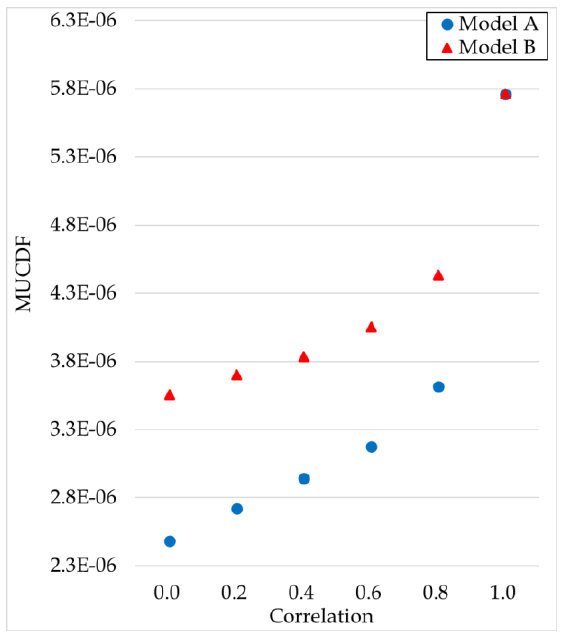
Figure 14. Plots of MUCDF versus seismic correlation.